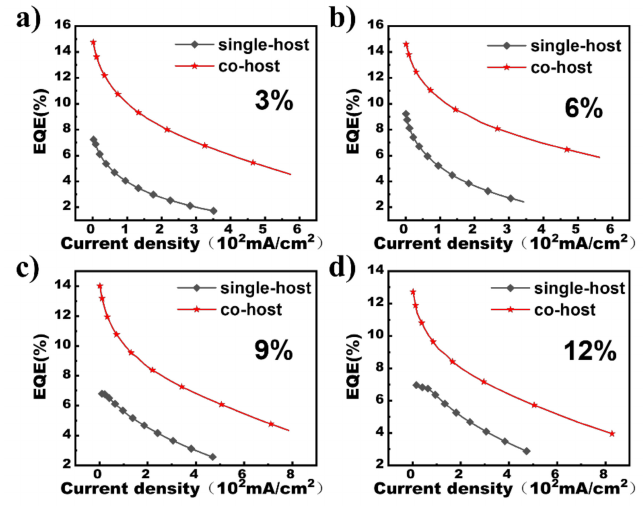
Figure 4. The EQEs of the co-host and single-host devices ( a – d ) for 3%,6%,9% and 12% doping concentration,